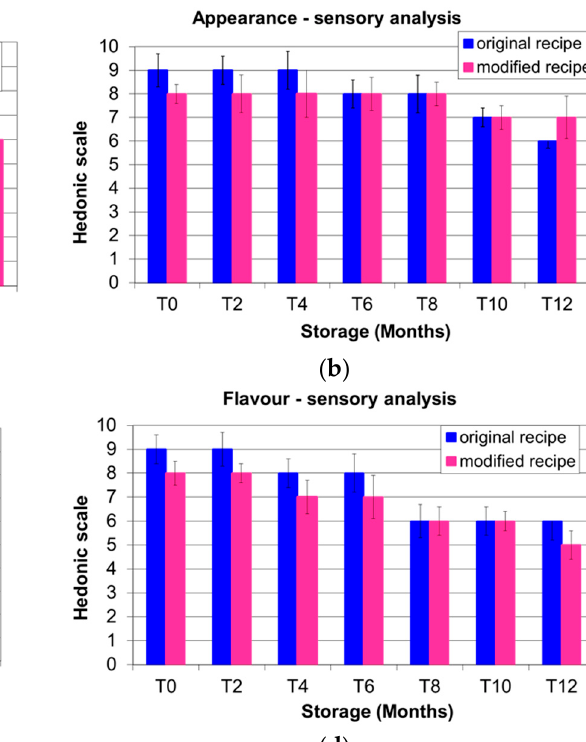
Figure 2. ( a ) Hardness of Italian Cantuccini biscuits prepared with the original recipe and the